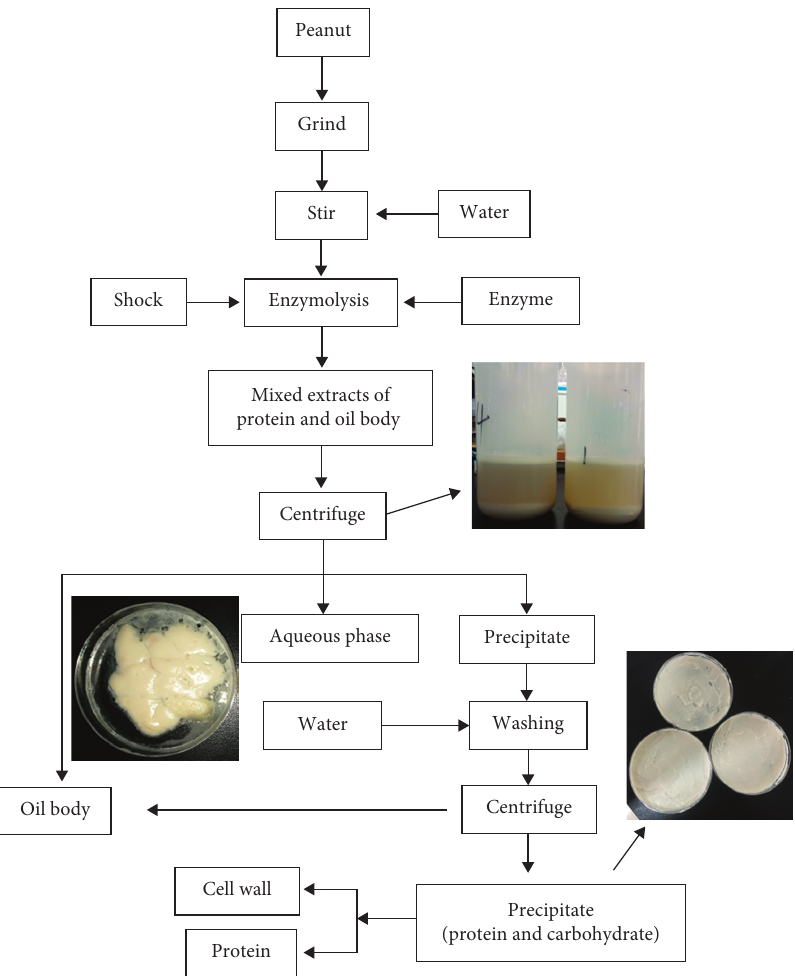
Figure 1: Process diagram of enzymatic extraction of peanut protein and oil